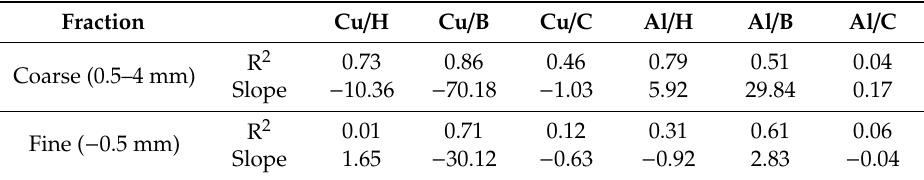
Table 5. The square of the correlation coefficient and the slope from the linear regression analysis between the major metals and light elements concentration identified by the PGAA.